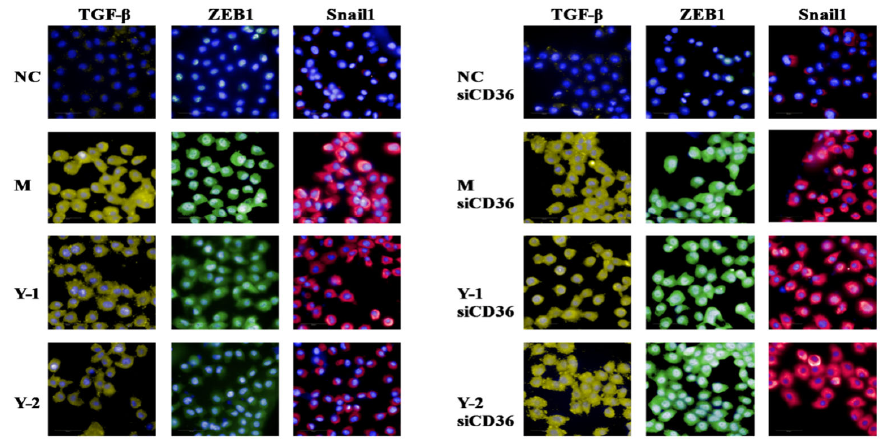
Figure 9. Cell immunofluorescence of fibrosis ‐ associated proteins TGF ‐β , ZEB1, and Snail1.